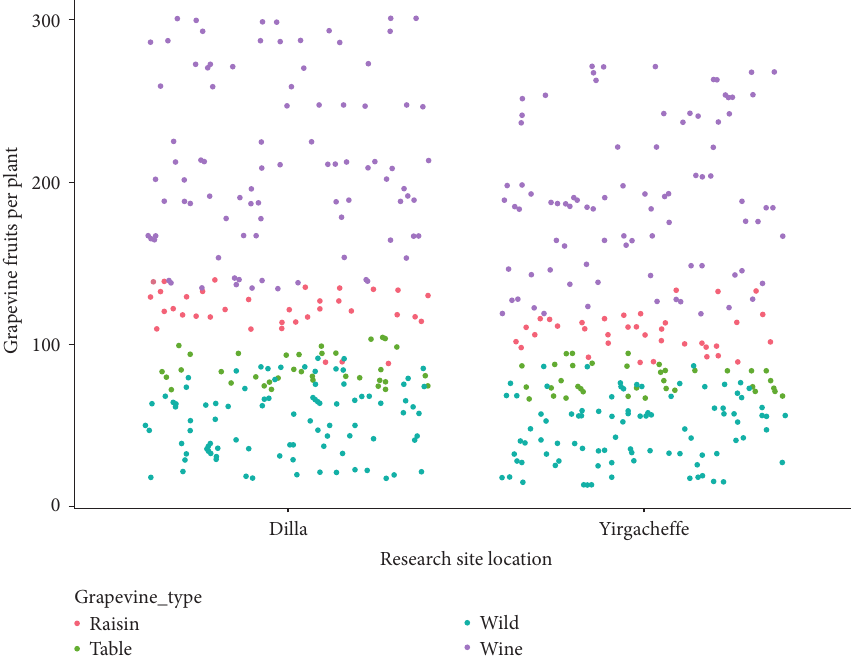
Figure 7: Response of fruit number to grapevine types and growth